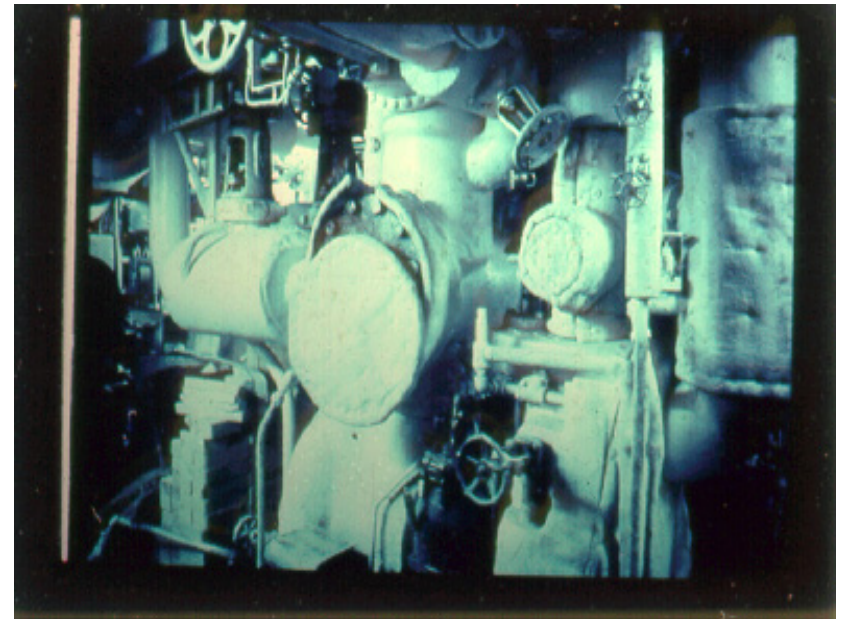
Figure 1. Asbestos insulation in the engine room of a ship. Photo courtesy of Irving J. Selikoff, MD Archives.